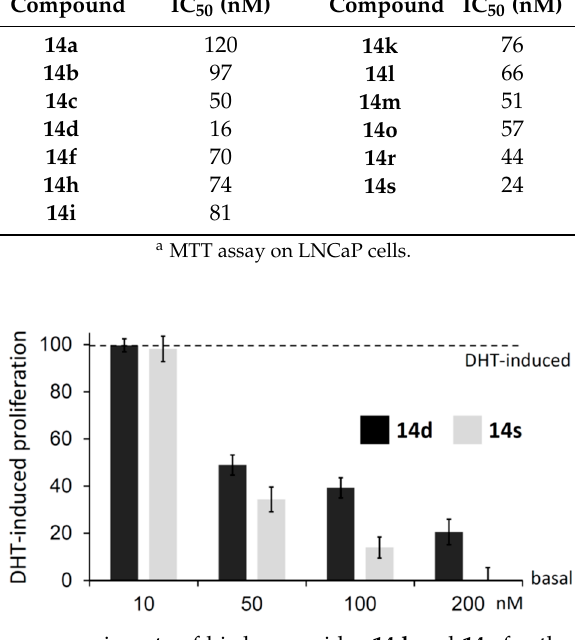
Figure 3. Dose-response experiments of bis-benzamides 14d and 14s for the growth inhibition of LNCaP cells by MTT assay.